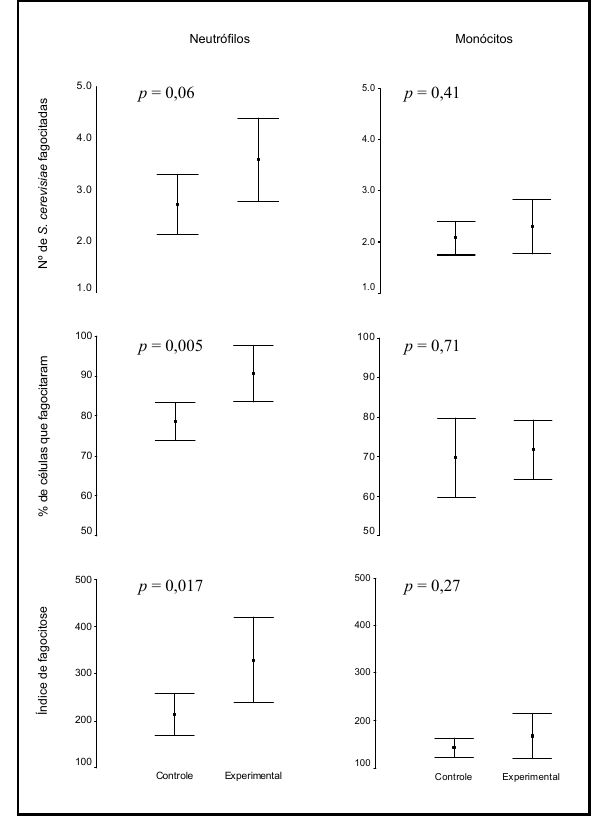
Figura – Capacidade fagocítica de neutrófilos e monócitos dos grupos controle (n = 8) e experimental (n = 8). As médias representam o número de Saccharomyces cerevisiae fagocitadas (acima), o percentual de fagócitos que fagocitaram (meio) e os índices de fagocitose (IF) (abaixo). As linhas verticais representam os intervalos de